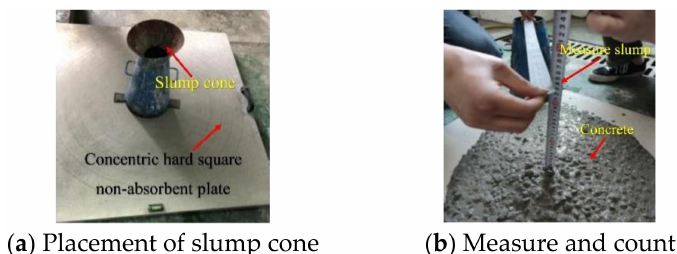
Figure 7. SCFFC slump